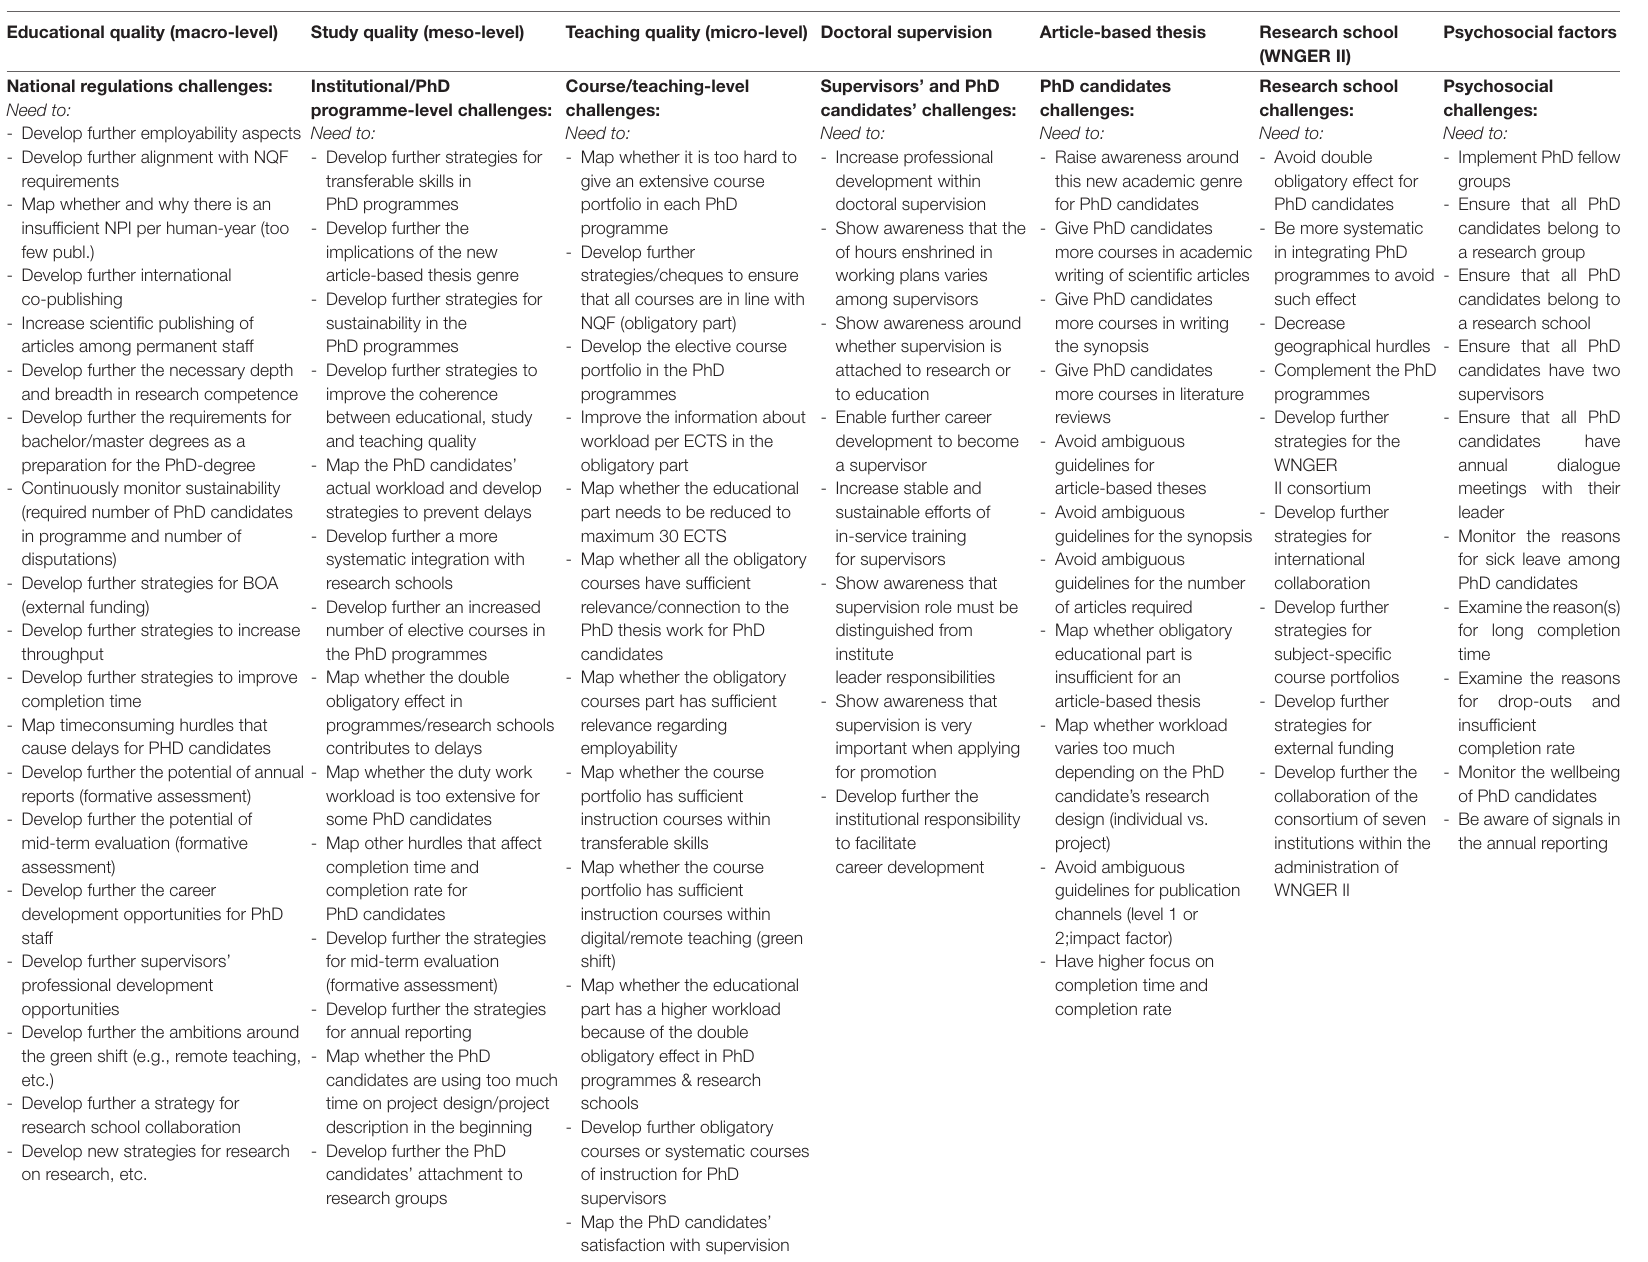
TABLE 2 | Actionable recommendations within the WNGER II consortium (challenges) in light of the frame factors in national policies. Educational quality